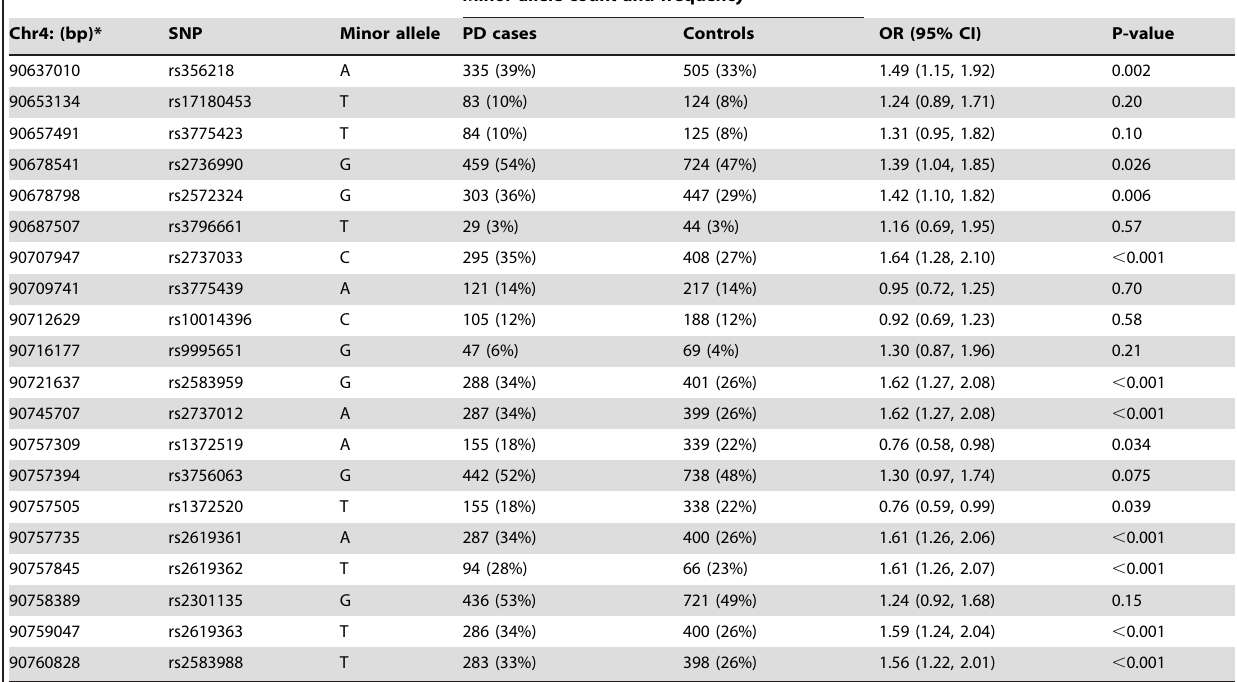
Minor allele count and